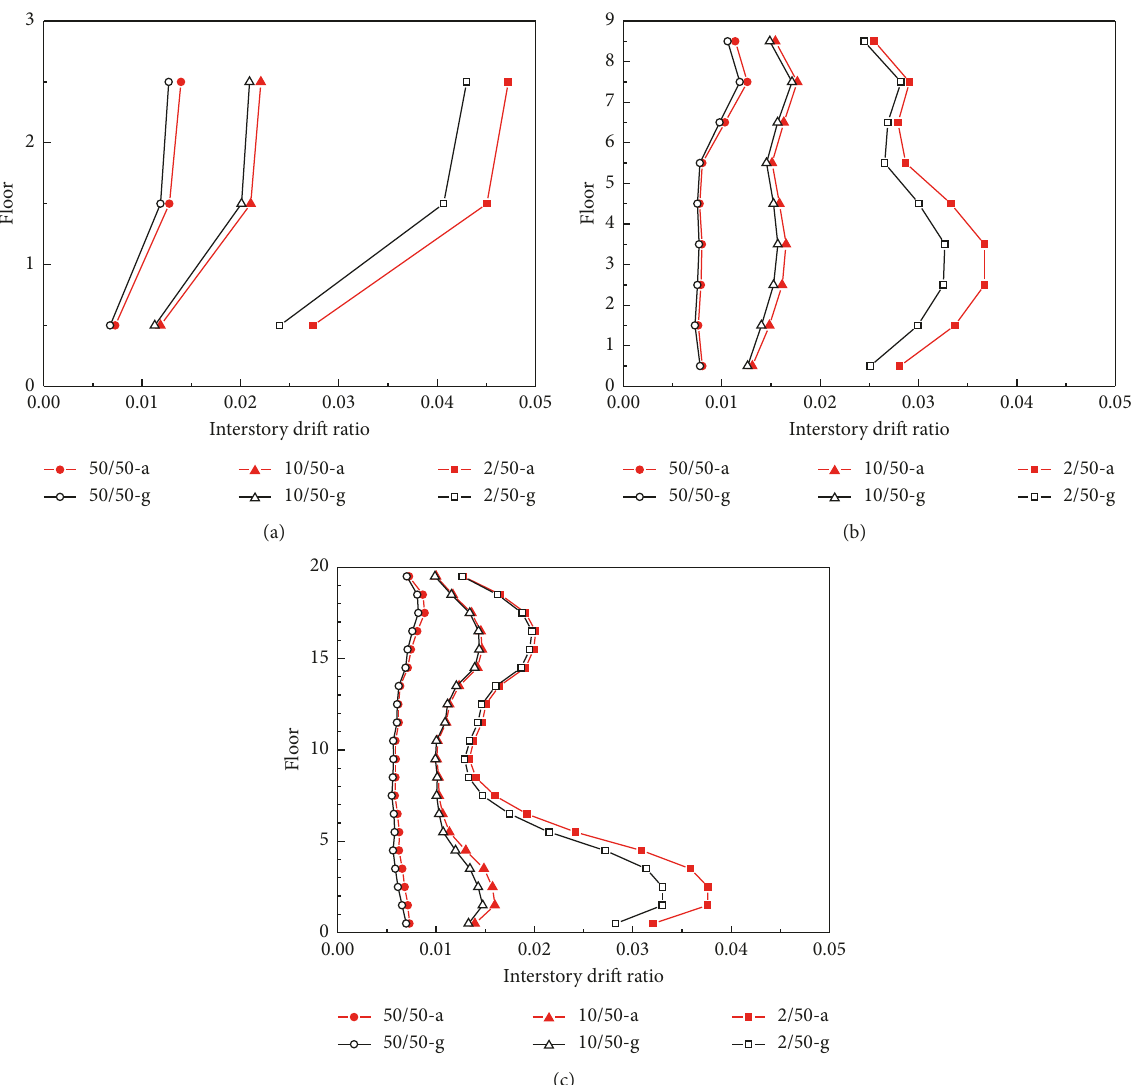
Figure 4: Arithmetic mean and geometric mean of interstory drift ratios for the (a) 3-, (b) 9-, and (c) 20-story structures at 50/50, 10/50, and 2/50 seismic hazard levels (“a” represents arithmetic mean and “g” represents logarithmic